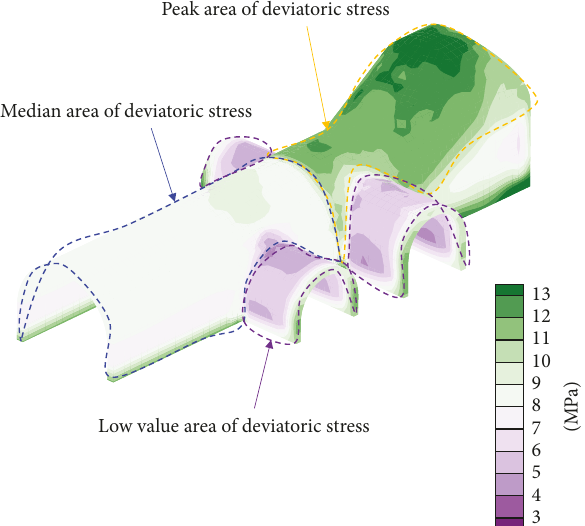
Figure 12: Distribution diagram of deviatoric stress of reinforced concrete wall brickwork.